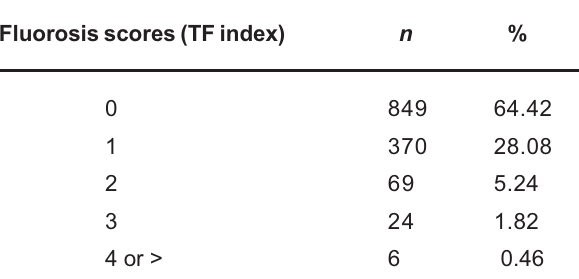
TABLE 1- Prevalence of dental fluorosis in scholars